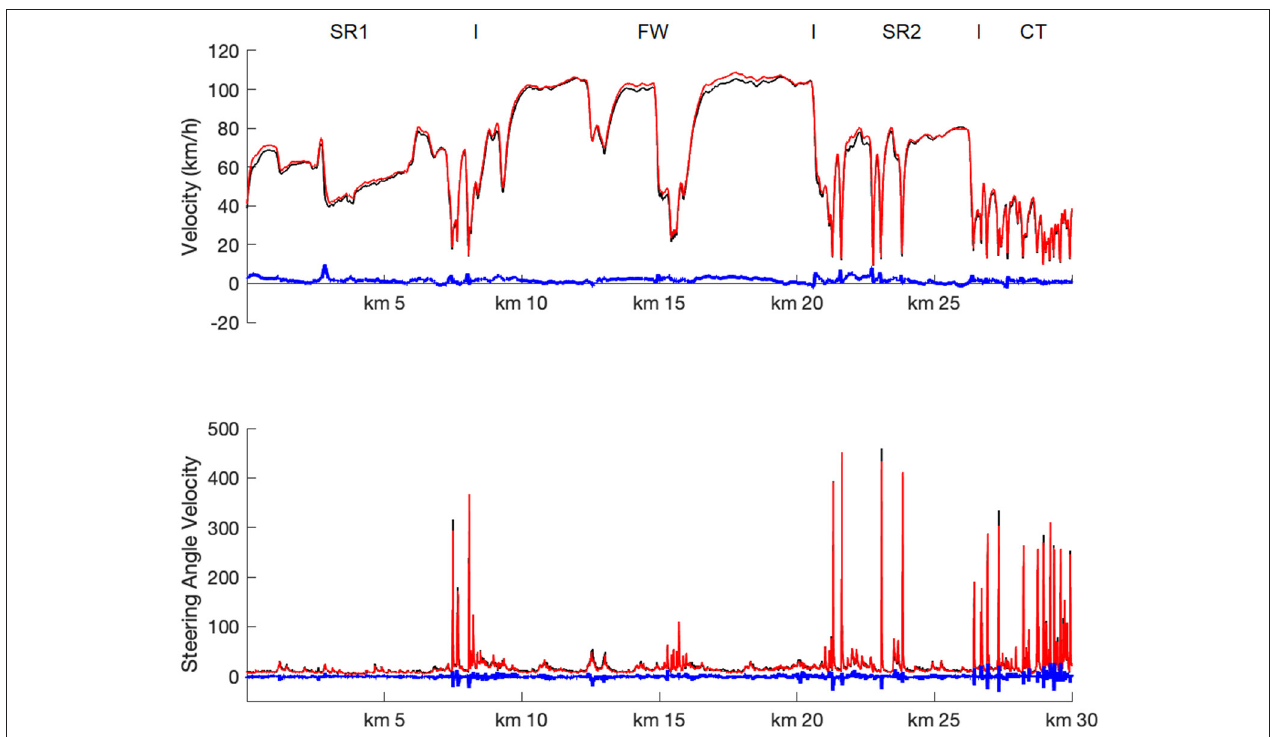
FIGURE 2 | Track-based analyses of driving parameter. Mean driving speed (upper row) and steering wheel angular velocity (lower row) as function of driving route, shown separately for MP1 (black), MP2 (red), and MP1 – MP2 differences (blue). Note that for each time point individual values of each participant were assigned to fix waypoints and then averaged 10-meter wise. SR1, first state road; FW, freeway; SR2, second state road; CT, city